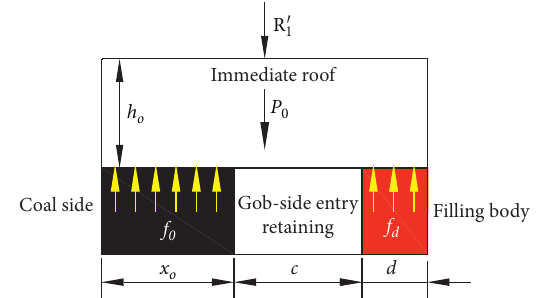
Figure 10: Mechanical model of surrounding rock support